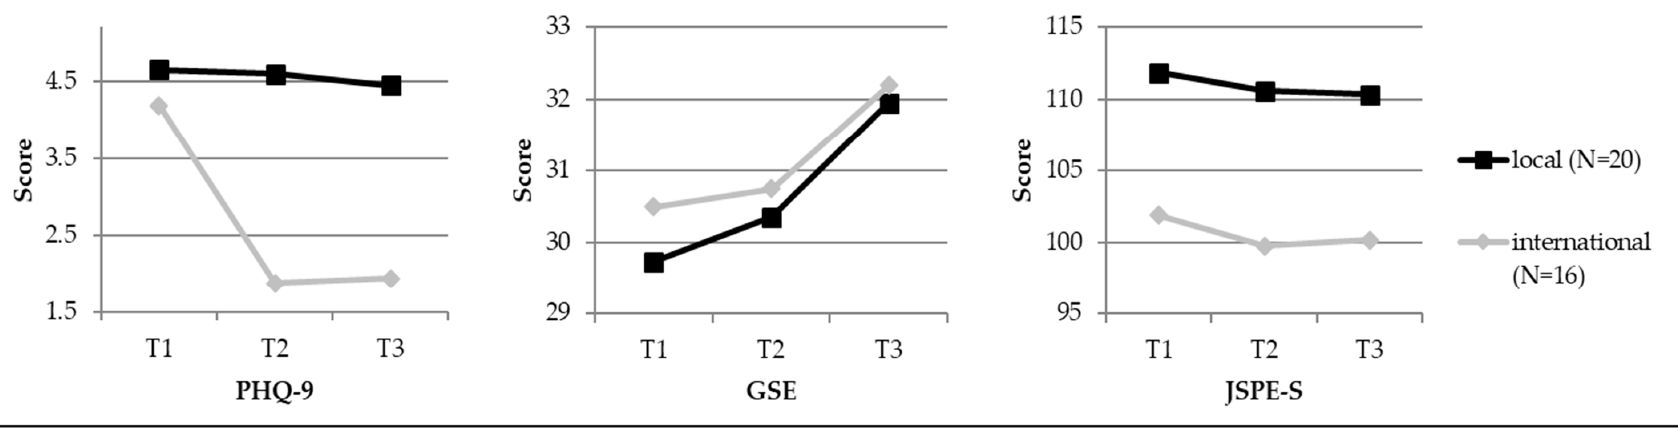
Figure 2. Line charts depicting differences between international and local students concerning the ‘PHQ ‐ 9’, the ‘GSE’, and the ‘JSPE ‐ S’.